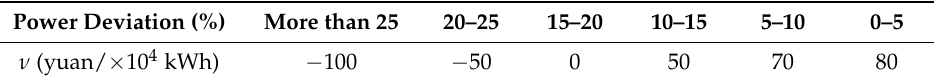
Table 3. Coefficients of the rewards and punishments corresponding to different photovoltaic (PV) power